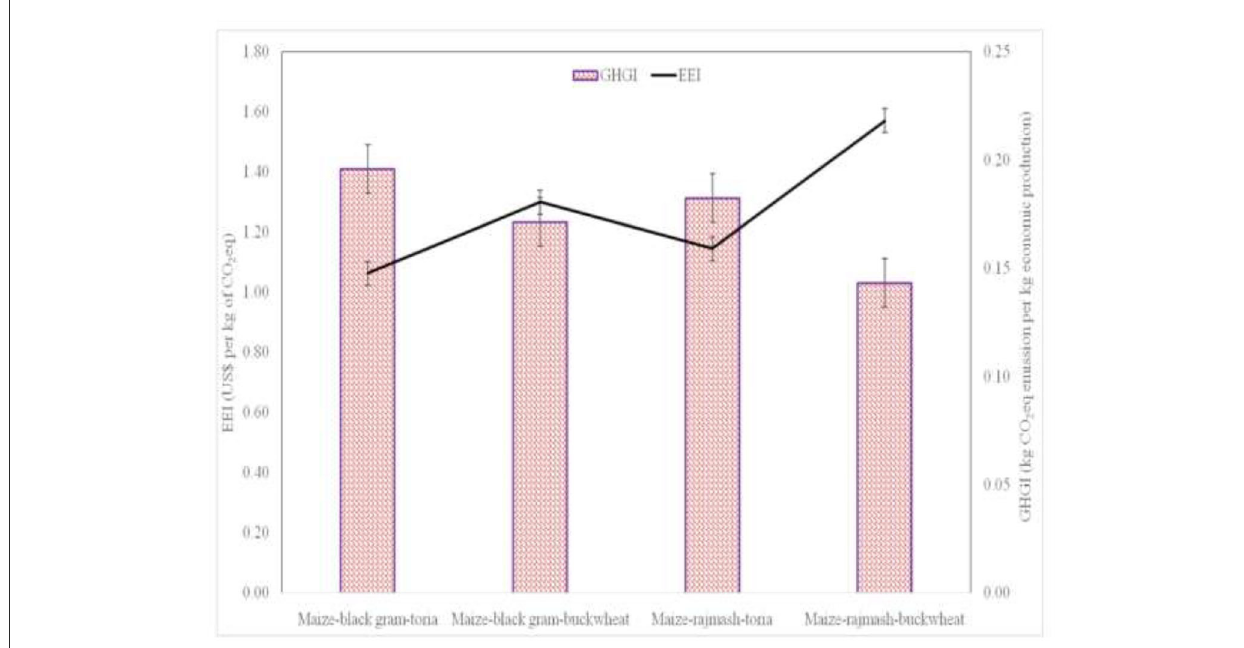
FIGURE5 Effect of diversified cropping on eco-efficiency index (EEI) and greenhouse gas intensity (GHGI). Error bar indicates the least significant difference (LSD) values at p = 0.05.